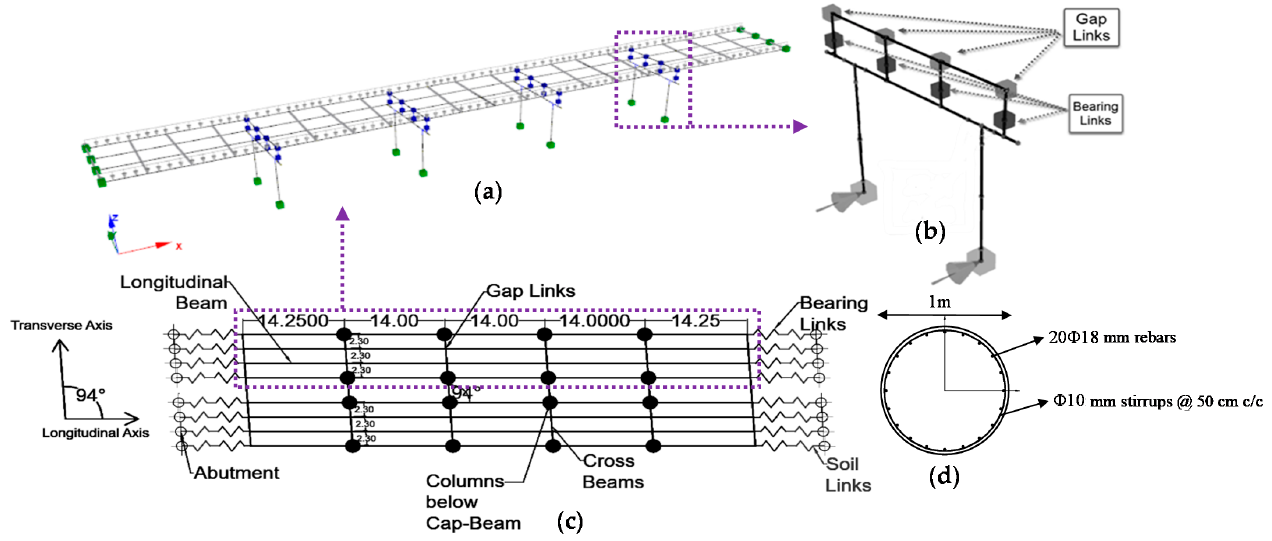
Figure 9. Benchmark bridge model: ( a ) 3DFB model of the bridge, ( b ) fiber-based model of bridge bent, and ( c ) sche- matic top view of the whole bridge, which includes two identical structures, a ( d ) column cross-section, and reinforce-